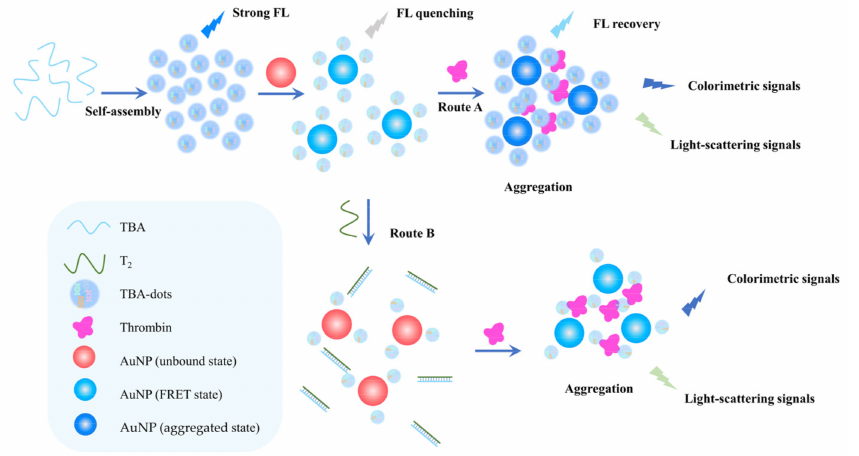
Figure 4. Schematic of the three signal reading modes of the thrombin sensor based on TBA dots/AuNPs. Adapted with permission from Ref. [76]. Copyright (2016),